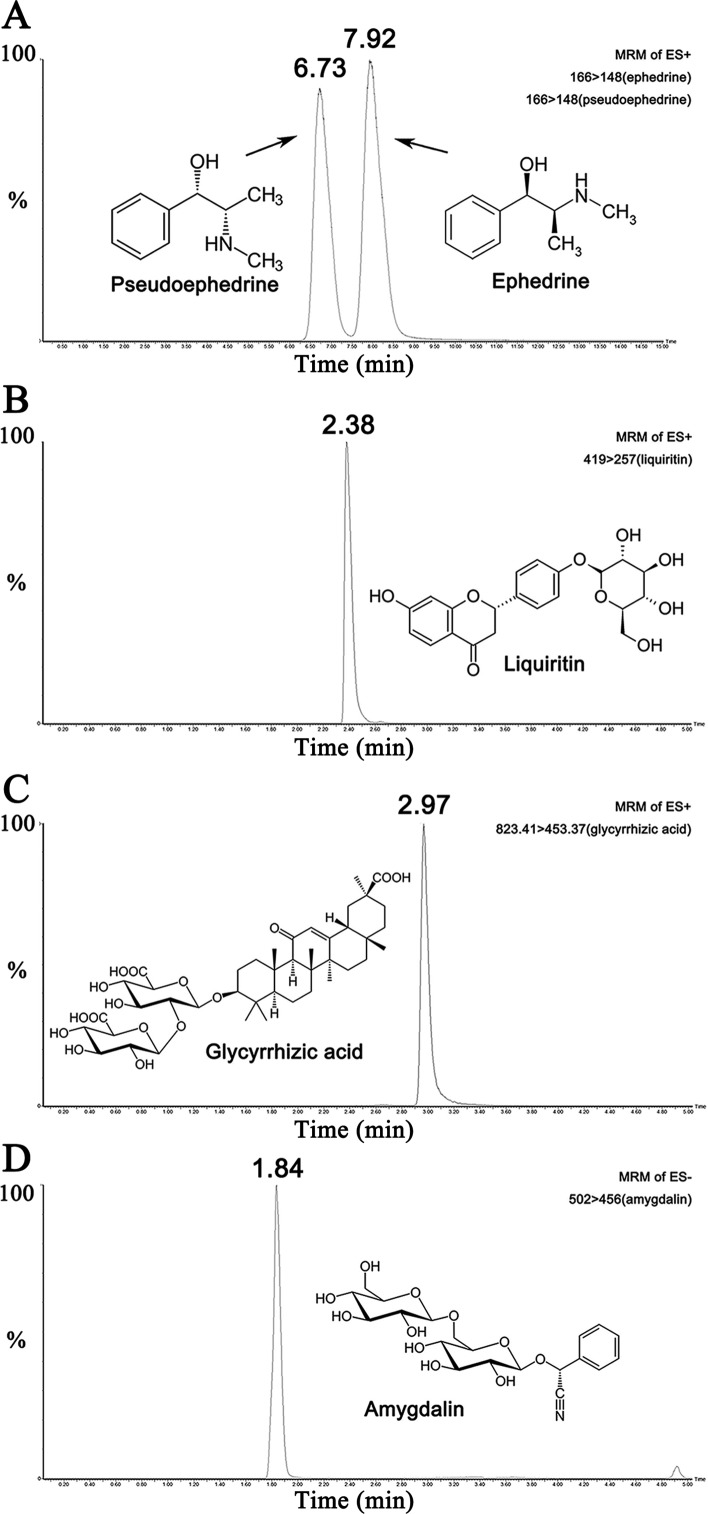
Representative chromatograms of the five compounds in reference standard solution. (A) Representative chromatograms of ephedrine (500 ng/ml) and pseudoephedrine (500 ng/ml) in standard solution. (B) Representative chromatogram of liquiritin (500 ng/ml) in standard solution. (C) Representative chromatogram of glycyrrhizic acid (500 ng/ml) in standard solution. (D) Representative chromatogram of amygdalin (500 ng/ml) in standard solution.